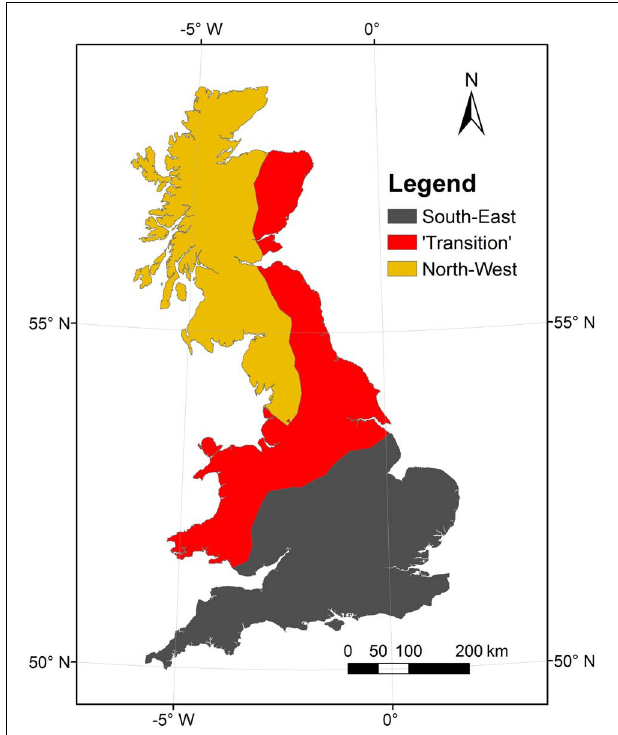
FIGURE 1 | Great Britain rainfall regions defined using k -means clustering technique applied in two